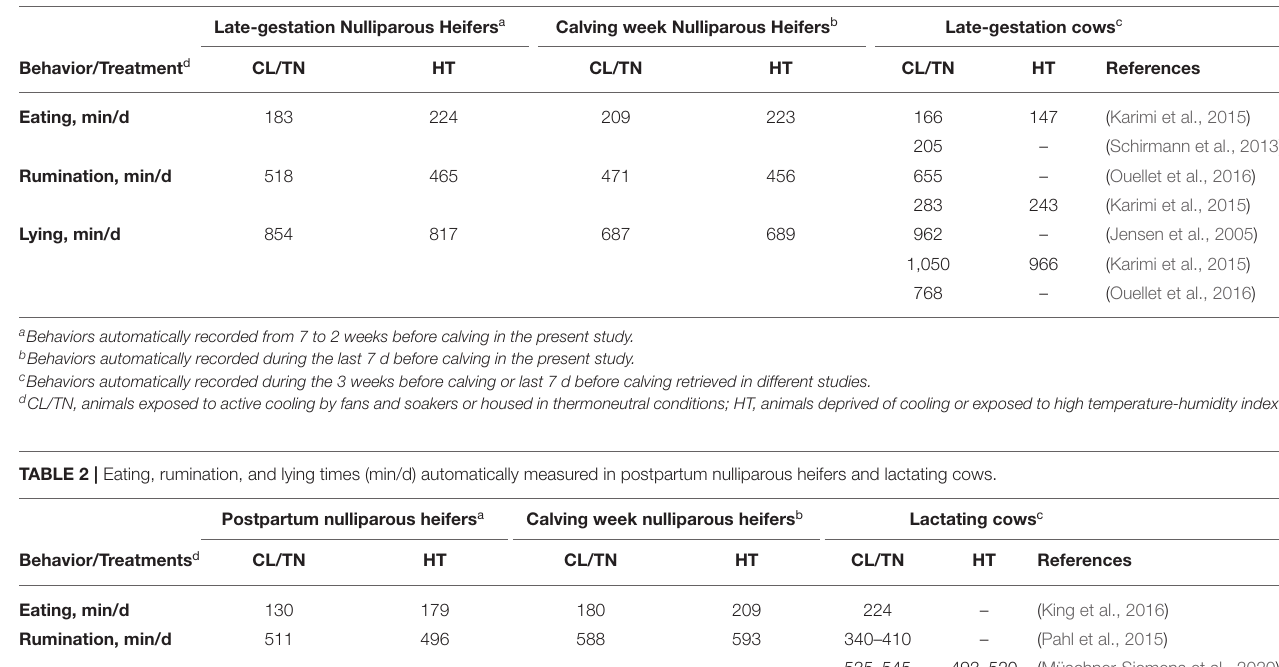
TABLE 1 | Eating, rumination, and lying times (min/d) automatically measured in late-gestation nulliparous heifers and late-gestation dry cows housed in different conditions.